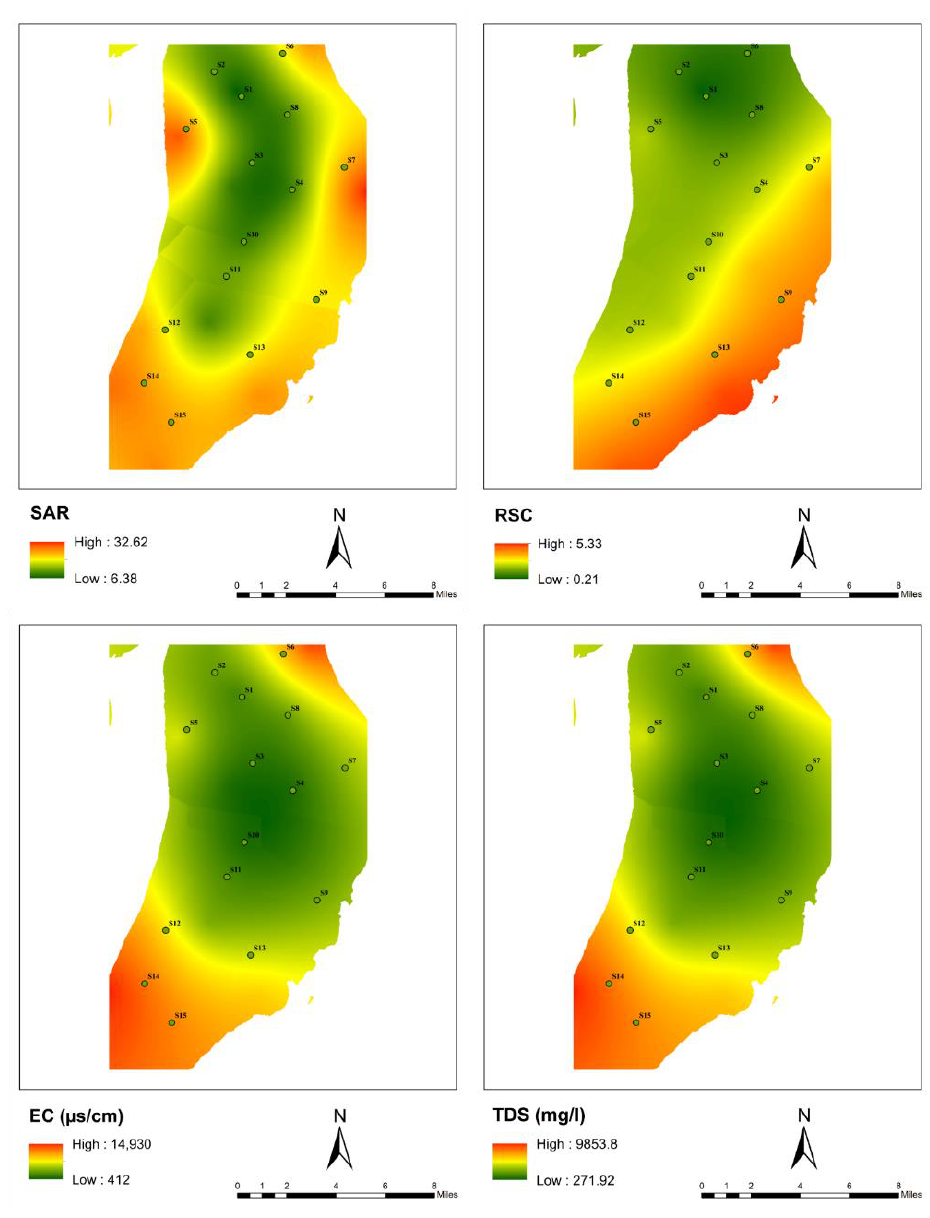
Figure 10. Water quality index map of the groundwater for irrigation purposes.